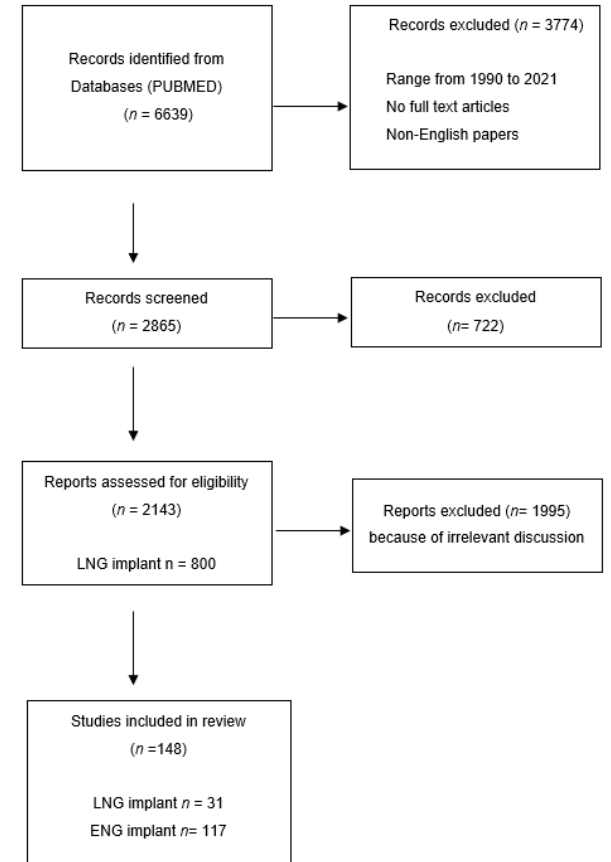
Figure 1. Flow diagram of study selection.